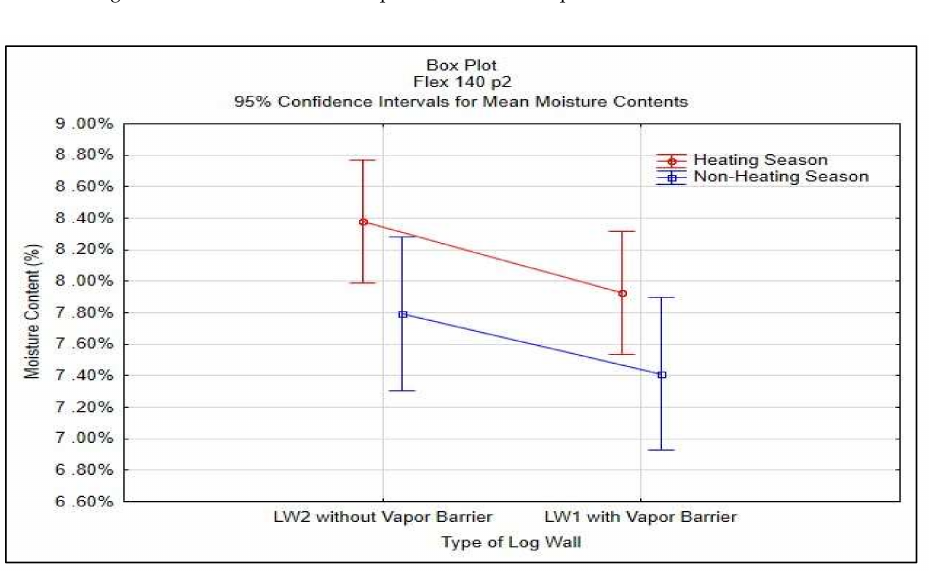
Figure 15. 95% Confidence Intervals for Mean Moisture Contests of STEICO Flex part